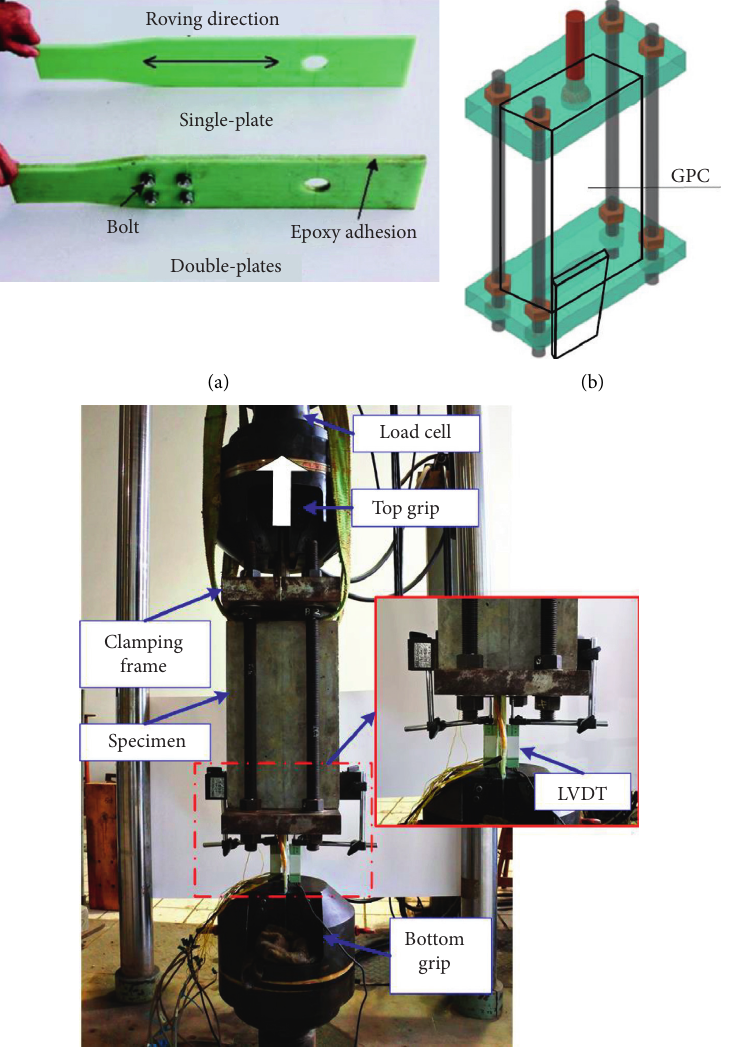
Figure 29: Plates arrangements and test setup studied by Xiong. (a) Plate arrangements. (b) Clamping frame. (c) Test